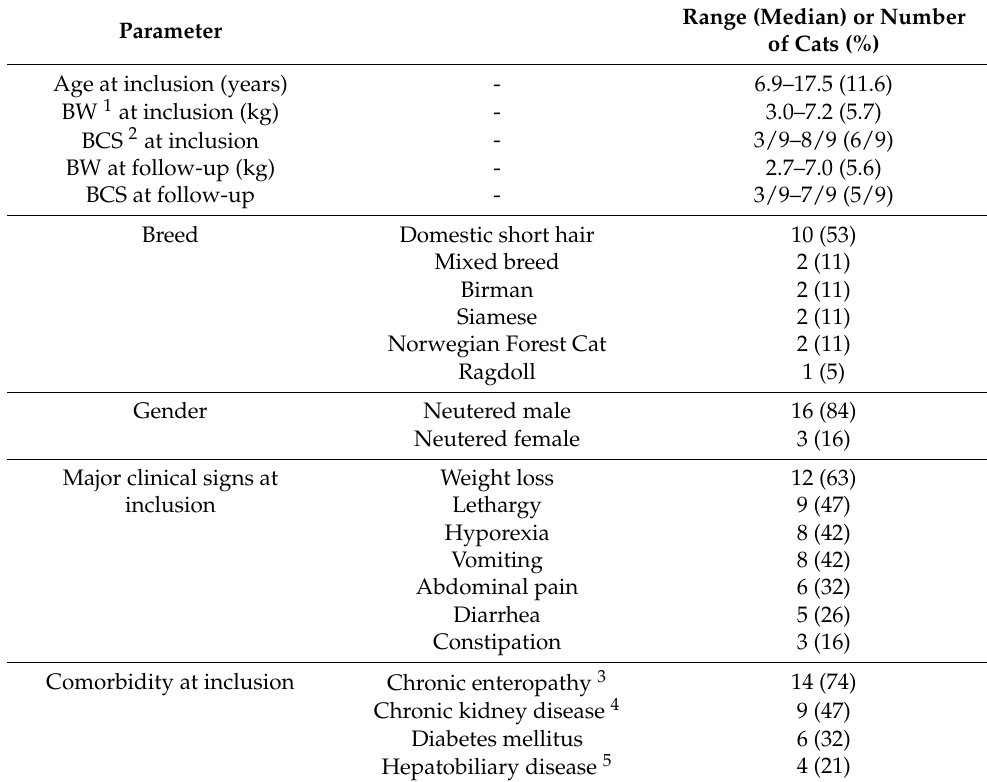
Table 1. Baseline data, clinical signs and comorbidities at inclusion and follow-up in 19 cats with presumed chronic pancreatitis treated with